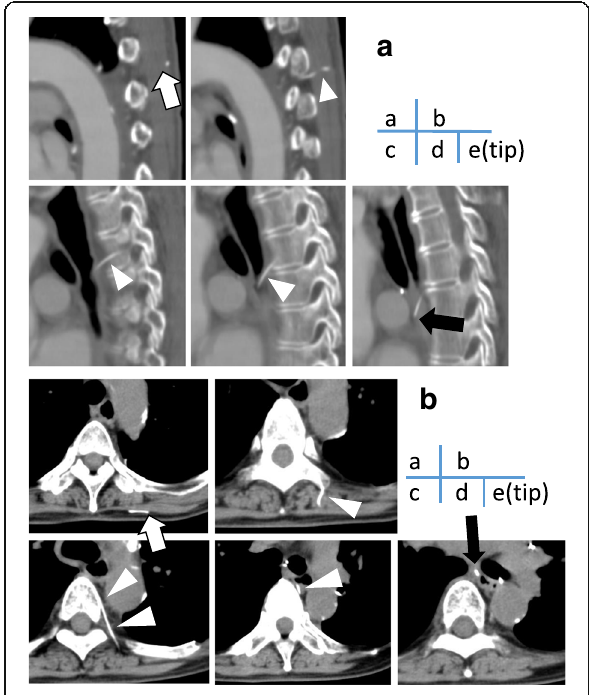
Fig. 2 Computed tomography images of the retained catheter fragment ( arrow ). The cut side of the catheter fragment is located at a depth of 6.3 mm from the skin surface ( white arrow ). The tip of the paravertebral catheter ( black arrow ) has been displaced to the posterior mediastinum and is located near the esophagus and trachea, on sagittal views ( a ) and axial views ( b